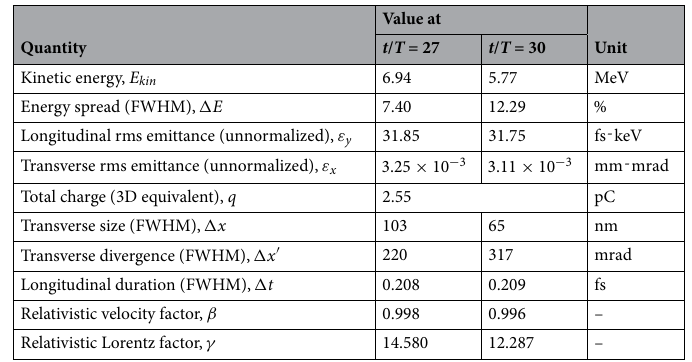
Table 3. Parameters of the bunch before extraction ( t / T = 27) and after extraction ( t / T = 30).